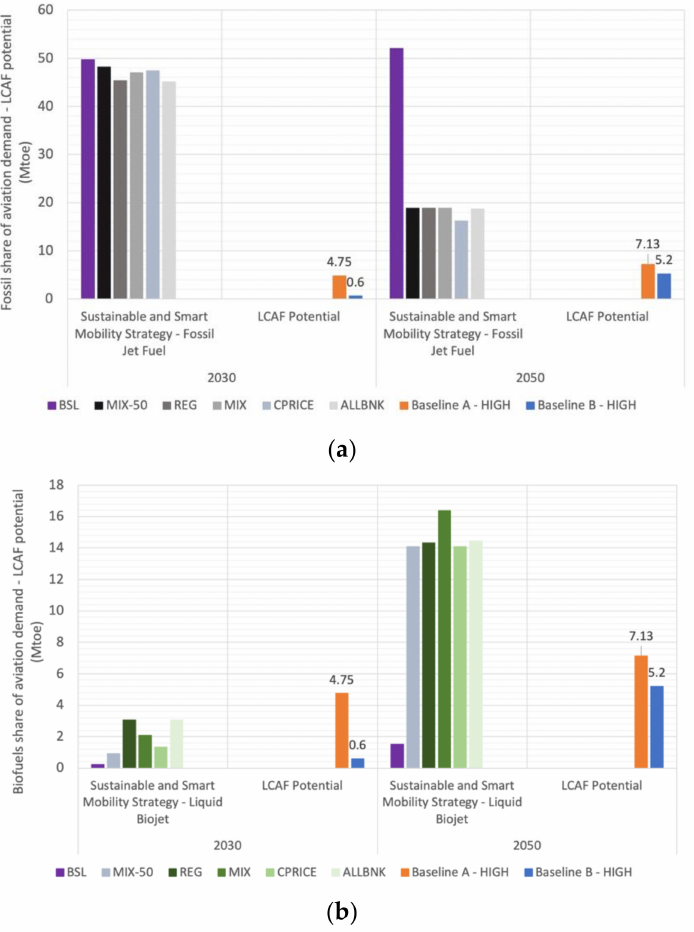
Figure 8. Comparison of EU-27 LCAF technical potential with ( a ) projected Fossil Jet Fuel demand, as determined in the present work, and ( b ) with projected Liquid Bio-Jet Fuel demand as reported